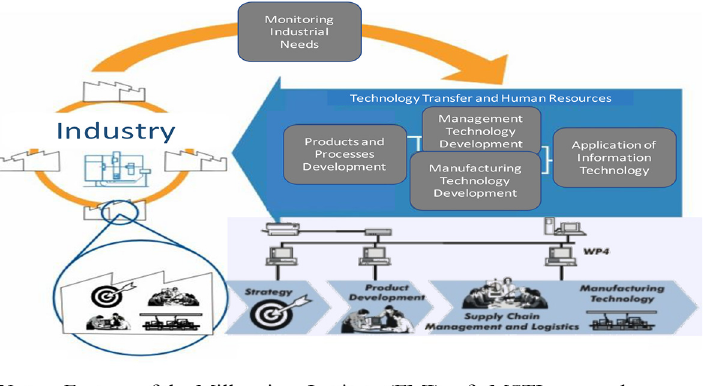
Figure 2. Model to support the business sector in